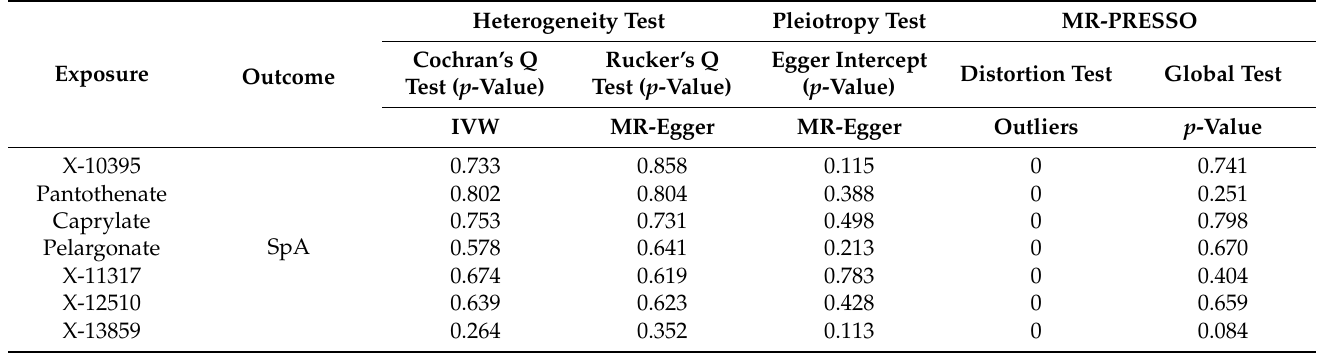
Figure 4. Scatter plot of MR analysis results between blood metabolites (pantothenate, caprylate, pelargonate, X-11317, X-12510, and X-13859) and spondyloarthritis. ( A ) Pantothenate and spondy- loarthritis; ( B ) caprylate and spondyloarthritis; ( C ) pelargonate and spondyloarthritis; ( D ) X-11317 and spondyloarthritis; ( E ) X-12510 and spondyloarthritis; ( F ) X-13859 and spondyloarthritis.